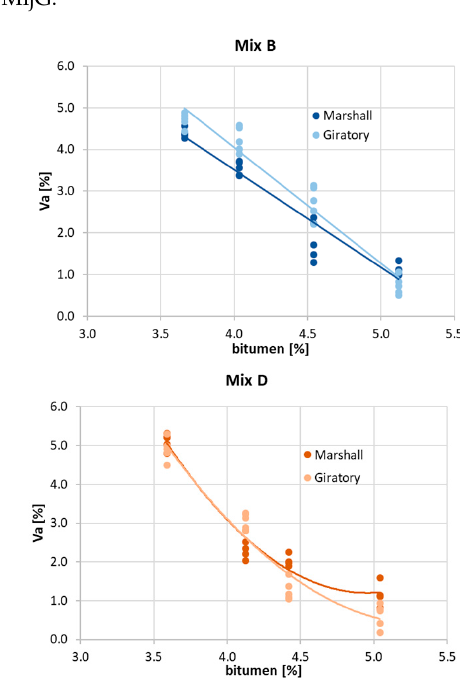
Figure 3. Air voids content. ( a ) MijM; ( b ) MijG.